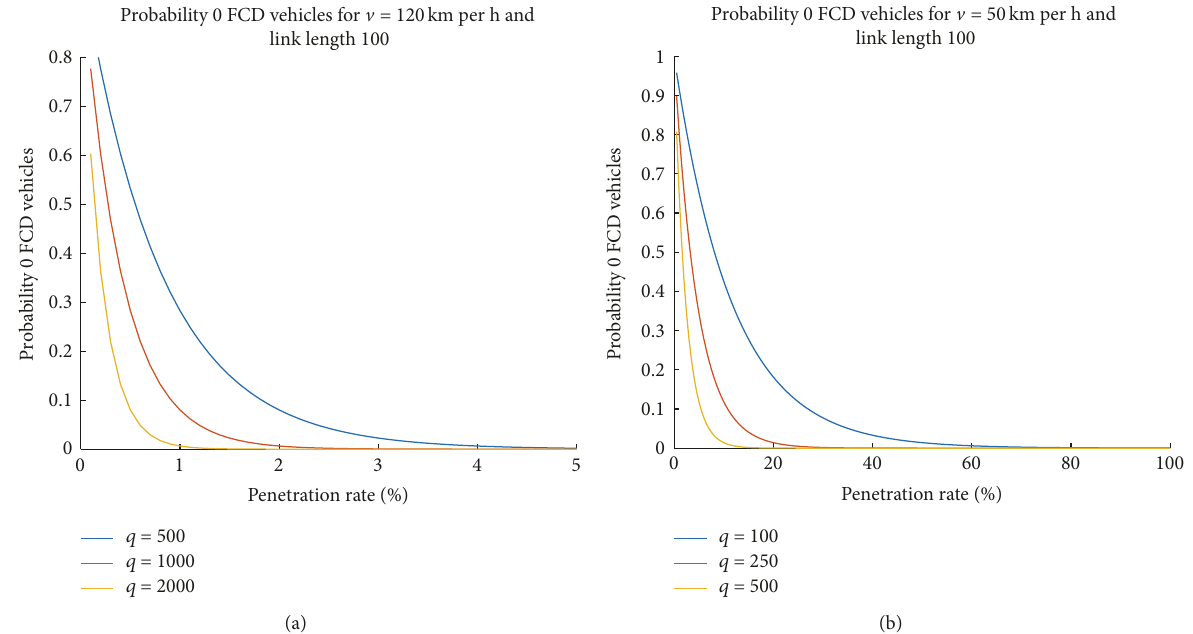
Figure 6: Estimation of the probability that not any floating car is observed during a 5-minute time interval on a road section of 100m length and different lane flows ( 𝑞 ), on a 3-lane motorway with speed limit 120 km/h (a), and on a one-lane urban road with speed limit 50km/h (b). 00.20.40.60.81